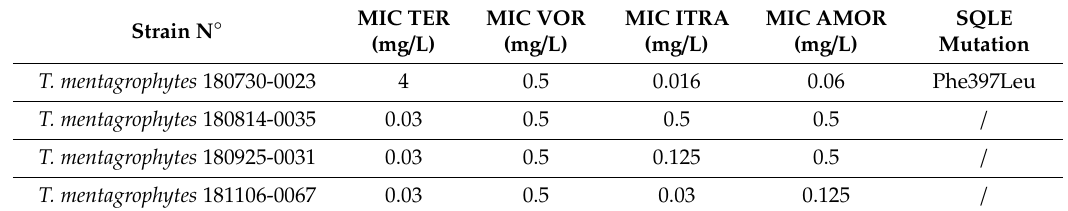
Table 3. Minimal inhibitory concentrations (MIC) against four antifungals and SQLE profile of the 5 strains of T. mentagrophytes isolated in the study. TER: terbinafine, VOR: voriconazole, ITRA: itraconazole, AMOR: amorolfine.